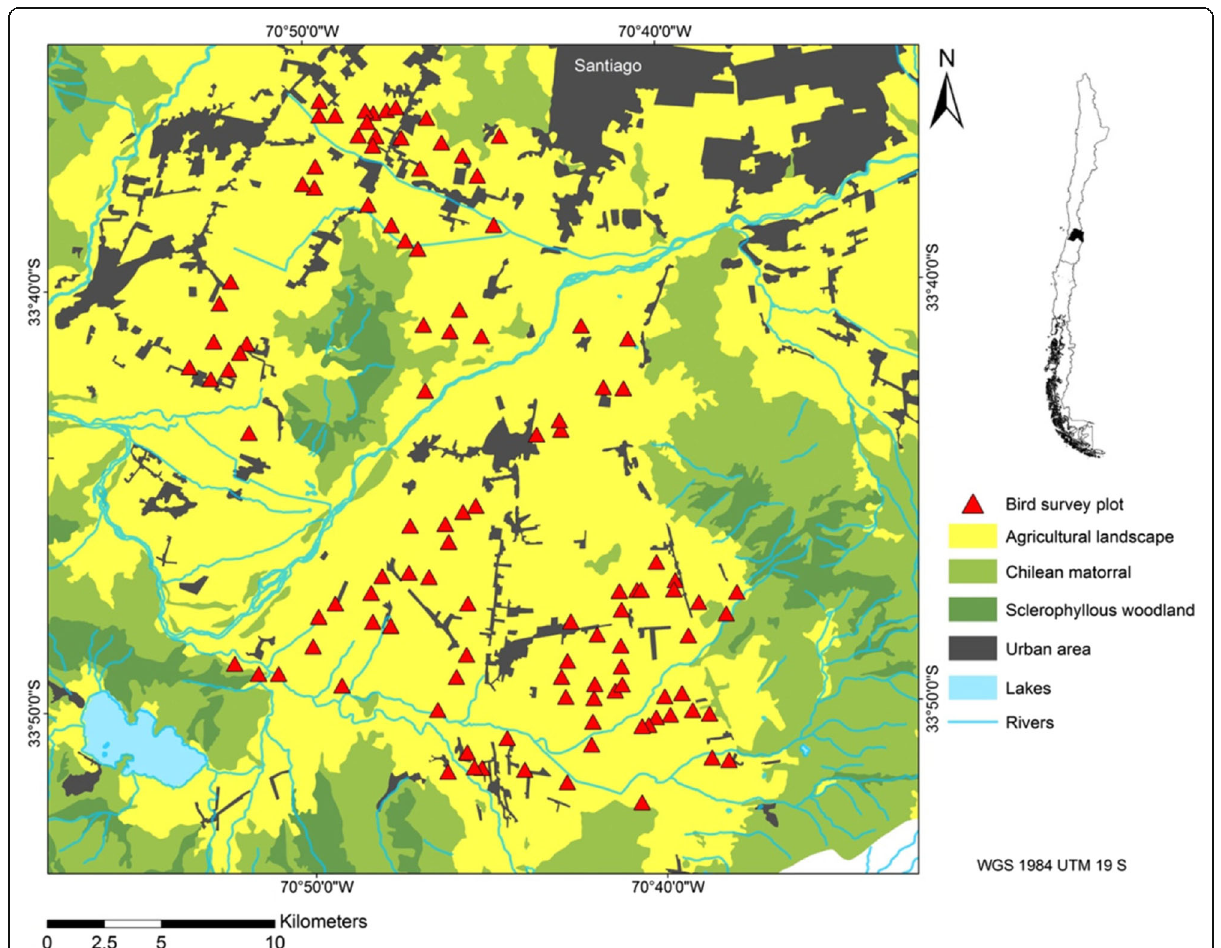
Fig. 1 Location of bird survey plots in agricultural areas around Santiago, Chile. Maipo river is shown in the middle of the map, and Santiago city is shown in grey at the top of the map